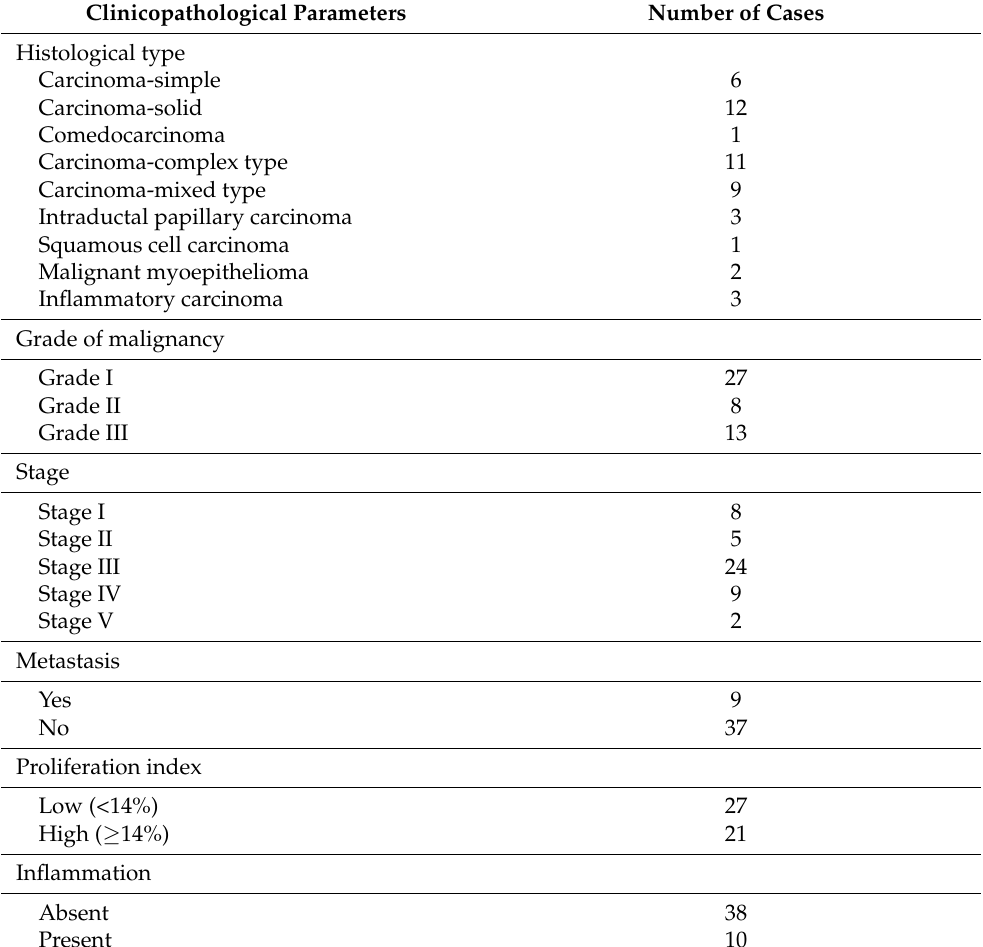
Table 1. Clinicopathological characteristics of the canine mammary tumors ( n =